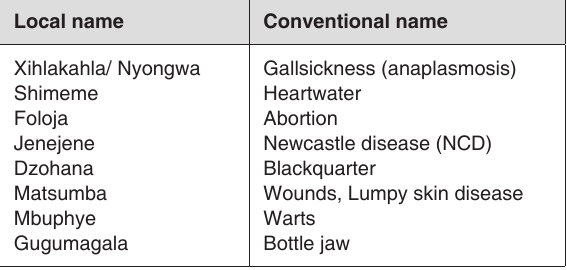
TABLE 1 List of Tsonga important animal disease names and corresponding conventional names Local